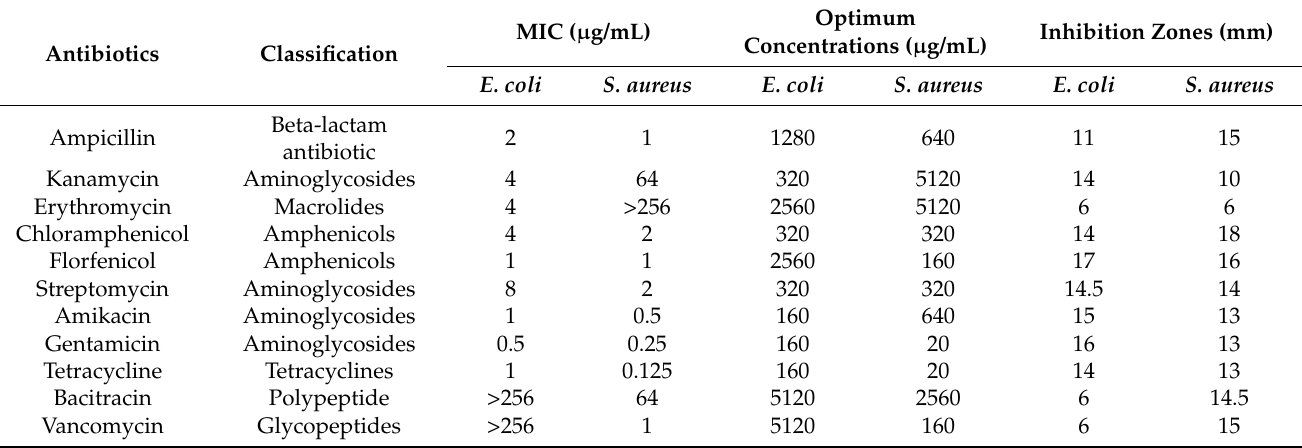
Table 2. MIC values and optimum concentrations of conventional antibiotics against E. coli ATCC 25922 and MRSA 43300. (Inhibition zones refers to optimum